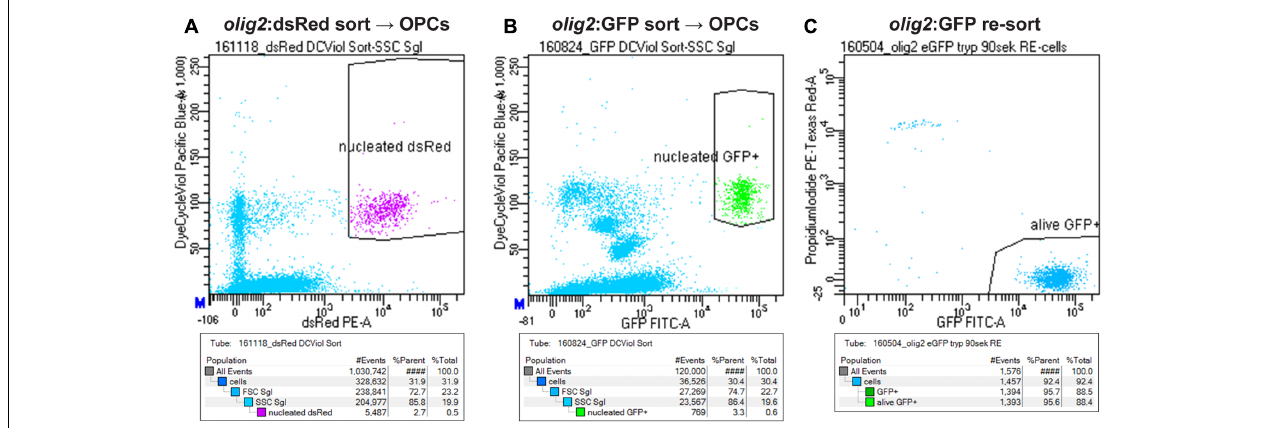
FIGURE 4 | Strategy to sort OPCs using FACS. (A) Gating of OPCs based on olig2 :dsRed and nuclear counter stain signals. (B) Gating of OPCs based on olig2 :GFP and nuclear counter stain signals. (C) Re-sort of FACsorted olig2 :GFP cells, counterstained with Propidium iodide to detect dead cells, shows a purity and viability of > 95% of the sorted population.